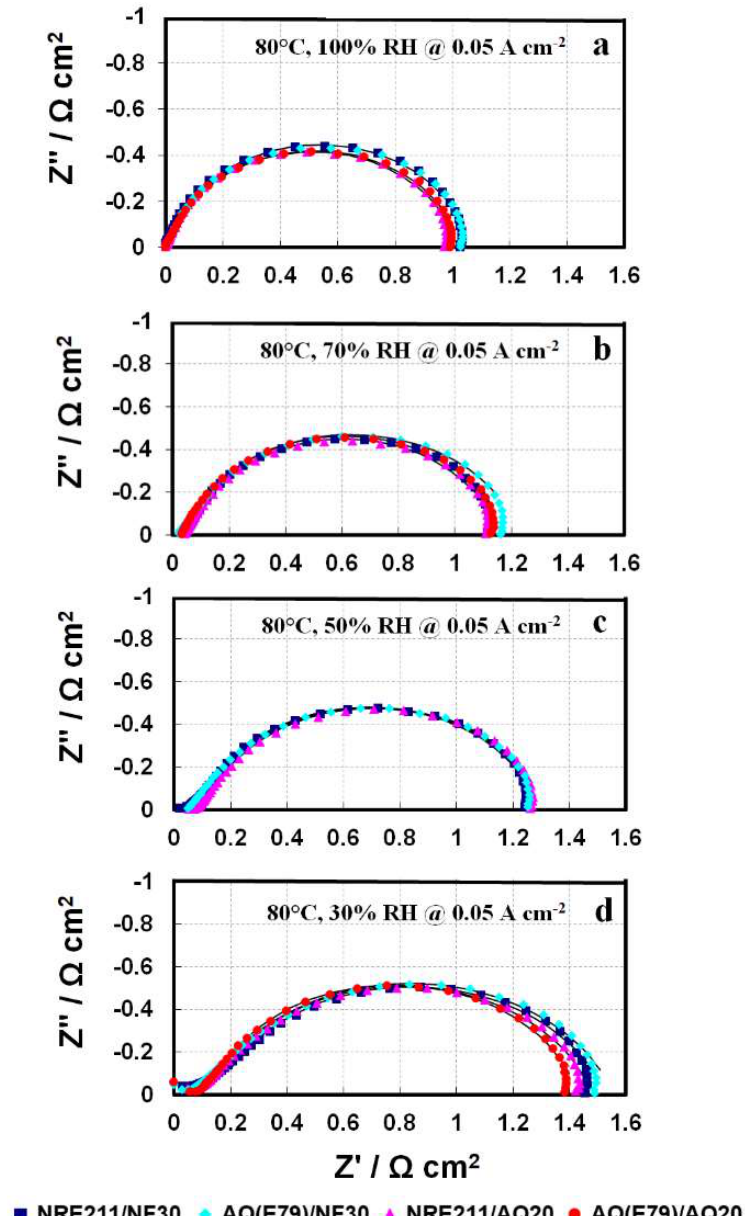
Figure 5. In-situ electrochemical impedance spectra obtained at 80 °C, 0.05 A cm −2 , and ( a ) 100%; RH ( b ) 70% RH; ( c ) 50% RH; and ( d ) 30% RH.